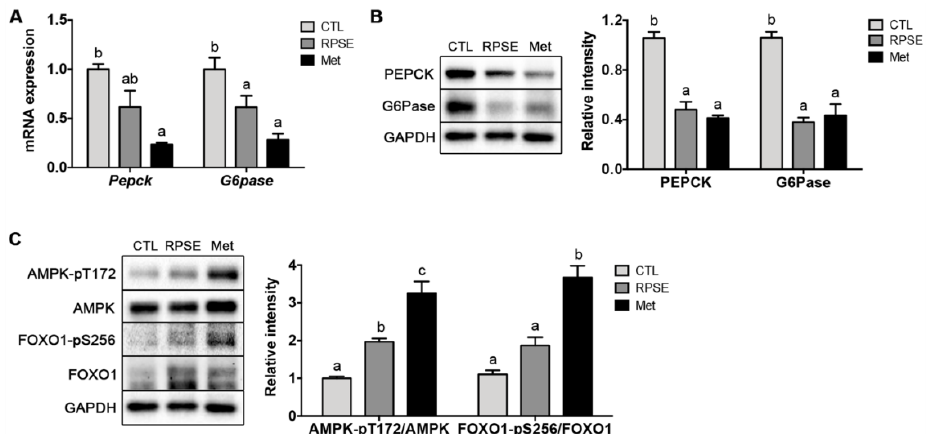
Figure 2. Red pepper seed extract (RPSE) improved the gene and protein expression related to hepatic gluconeogenesis in db/db mice. ( A ) mRNA expression of Pepck and G6Pase . ( B ) representative immunoblotting of PEPCK and G6Pase. ( C ) Representative immunoblotting of AMPK and FOXO1. The relative intensities by densitometry are shown. Expression levels were normalized to GAPDH. CTL, db/db mice treated with vehicle; RPSE, db/db mice treated with RPSE 200 mg/kg bw; Met, db/db mice treated with metformin 150 mg/kg bw. Values are expressed as mean ± SEM ( n = 4). a–c Means in the row indicated by different alphabets are significantly different between groups ( p < 0.05). AMPK, AMP-activated protein kinase; FOXO1, forkhead box protein O1; PEPCK, phosphoenolpyruvate carboxykinase; G6Pase, glucose 6-phosphatase; GAPDH, glyceraldehyde 3-phosphate dehydrogenase.